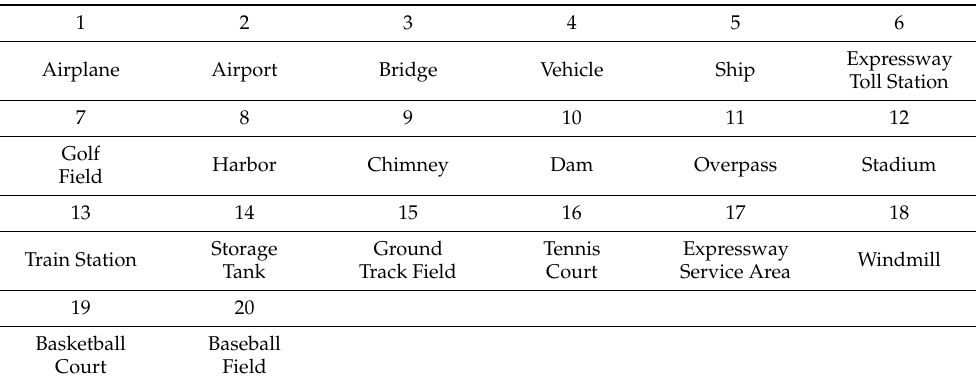
Table 3. The 20 object classes in DIOR